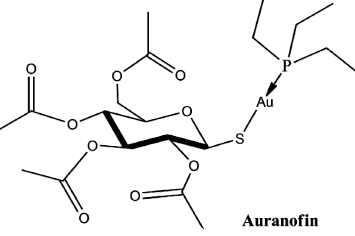
Figure 1. Schematic representation of Auranofin.